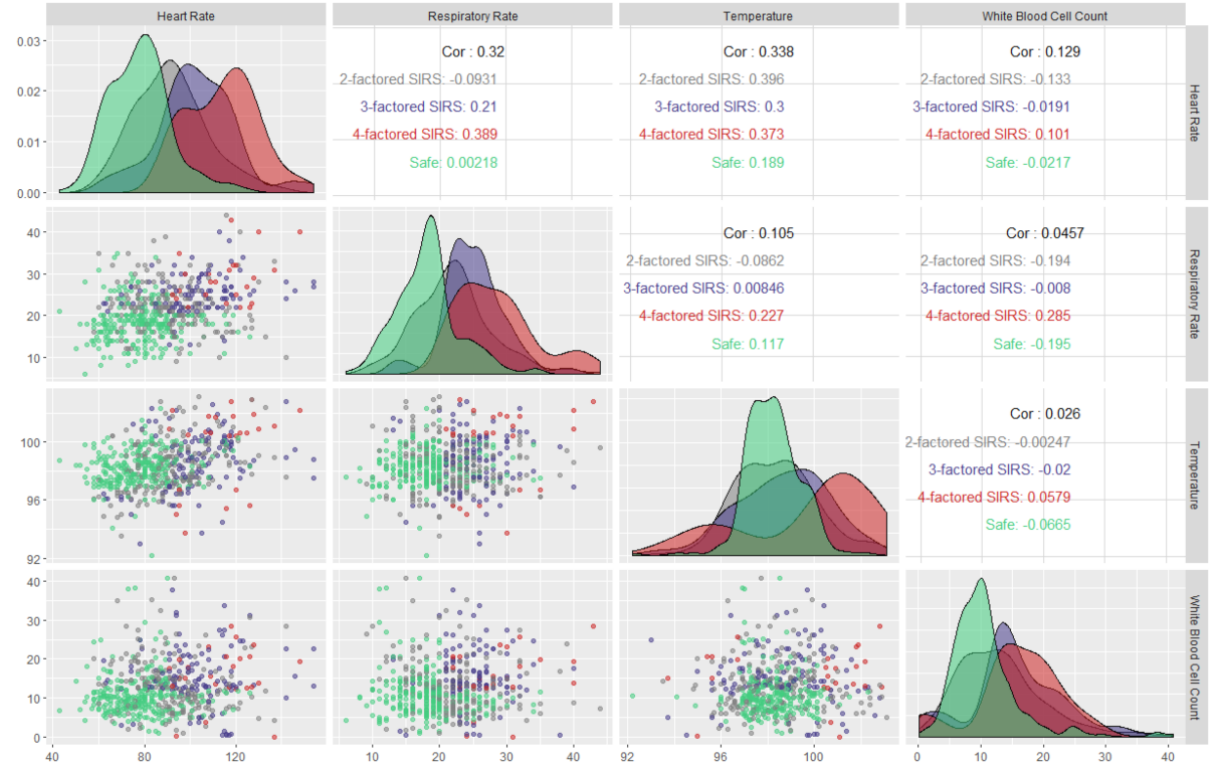
Figure 6. Facet grid illustration of sepsis-2 (SIRS) parameters to capture the underlying relationship between parameters and the most prevalent sepsis scenario in the intensive care unit. SIRS: systemic inflammatory response